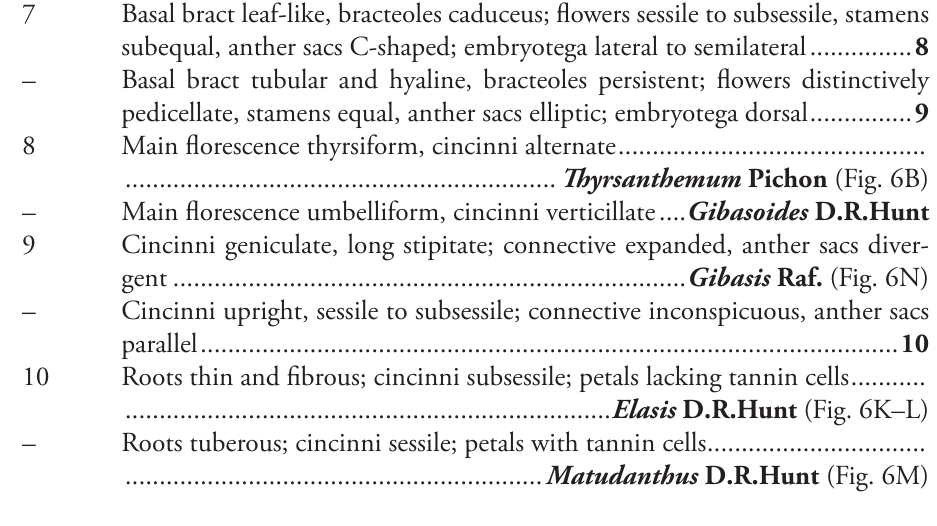
Fig. 6K–L Tradescantia sect. Coholomia D.R.Hunt, Kew Bull. 35(2): 440. 1980., Syn. nov. Type species. T. guatemalensis C.B.Clarke ex Donn.Sm. [ ≡ E. guatemalensis (C.B.Clarke ex Donn.Sm.) M.Pell.].